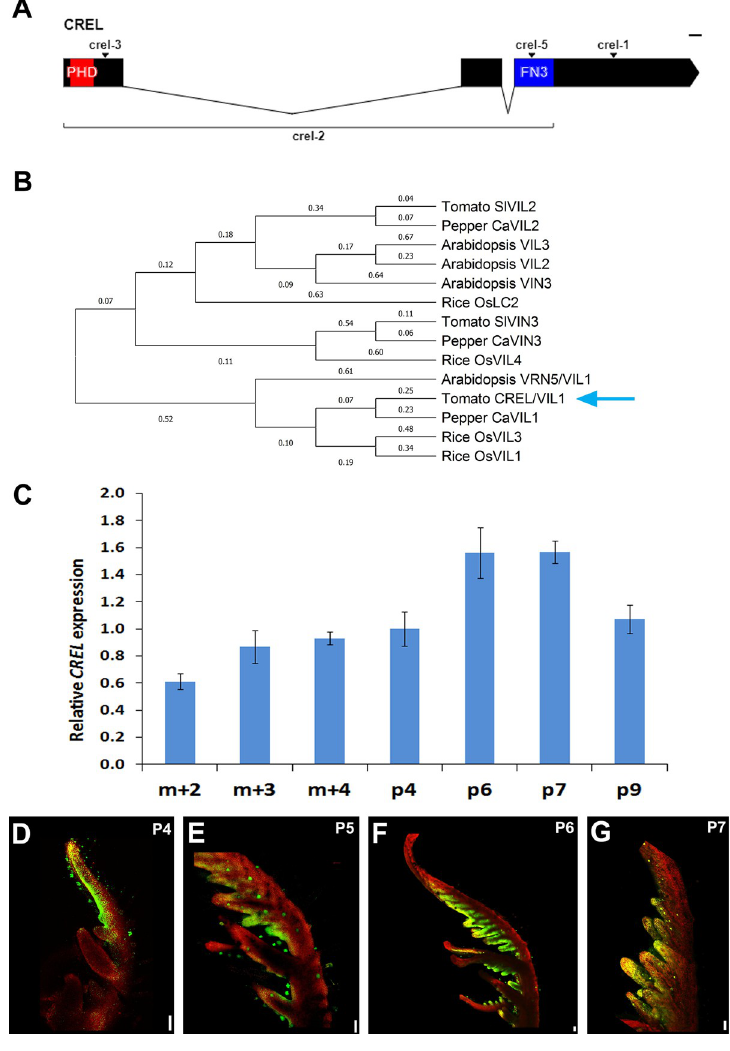
Fig 3. CREL encodes a VRN5/VIL1 homolog expressed at late stages of leaf development. (A) A diagram of the CREL (Solyc05g018390) gene. The boxes indicate exons and the combining lines introns. The location of the mutation in 4 crel alleles is indicated. (B) A phylogenetic tree of the tomato, Arabidopsis, rice and pepper VIL proteins, constructed using MEGA X [54,55]using a Maximum Likelihood method. Branch lenghts represent the expected number of substitutions per site. The blue arrow points to CREL. (C) qRT-PCR analysis of CREL mRNA expression at successive developmental stages of the 5th leaf. m+2, 3, or 4 represents the meristem and the 2, 3, or 4 youngest leaf primordia, respectively. P4-P9 represent isolated leaf primordia at the respective developmental stage (see Fig 1). Error bars represent the SE of at least three biological replicates. (D-G) Confocal images of leaf primordia of the indicated stages, expressing pCREL >> YFP , using the transactivation system, as in Fig 2. P4-P7 represent the 4 th -7 th youngest leaf primordia, respectively. In G, a leaflet from a P7 primordium is shown. Scale bars: 0.1